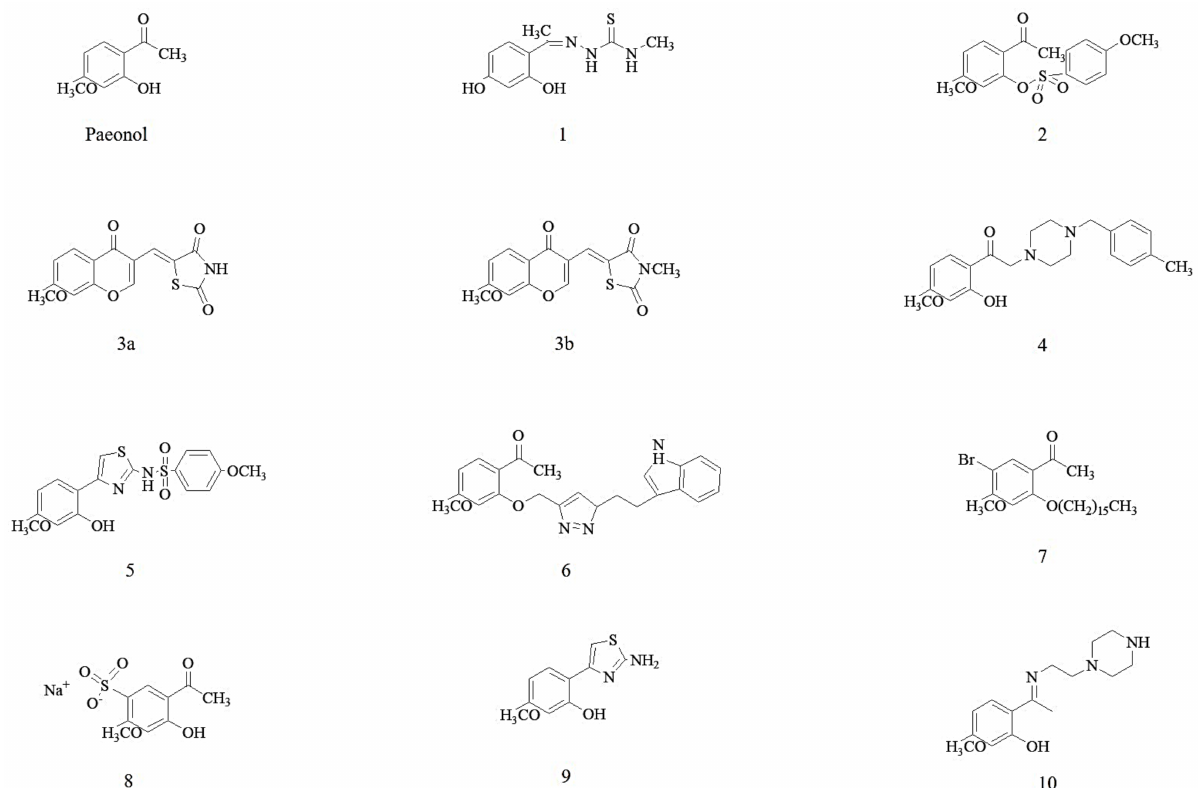
Figure 1. Chemical structures of paeonol and its derivatives ( 1 – 10 ). The derivatives are formed with thiosemicarbazone- like analogs ( 1 ), phenylsulfonyl-like analogs ( 2 ), chromonylthiazolidines-like analogs ( 3a and 3b ), donepezil-like analogs ( 4 ), aminothiazole-like analogs ( 5 ), tryptamine hybrid analogs ( 6 ), alkyl ether analogs ( 7 ), paeononlsilatie sodium ( 8 ), aminothiazole-like analogs ( 9 ), and piperazin-like analogs ( 10